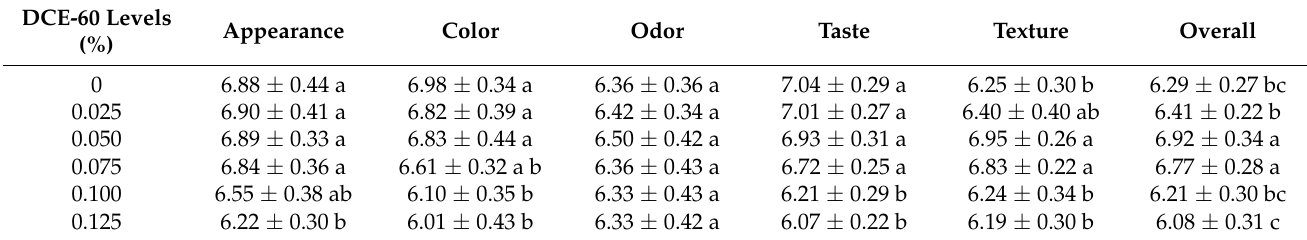
Table 4. Acceptability score for the surimi gel without and with DCE-60 added at different levels.